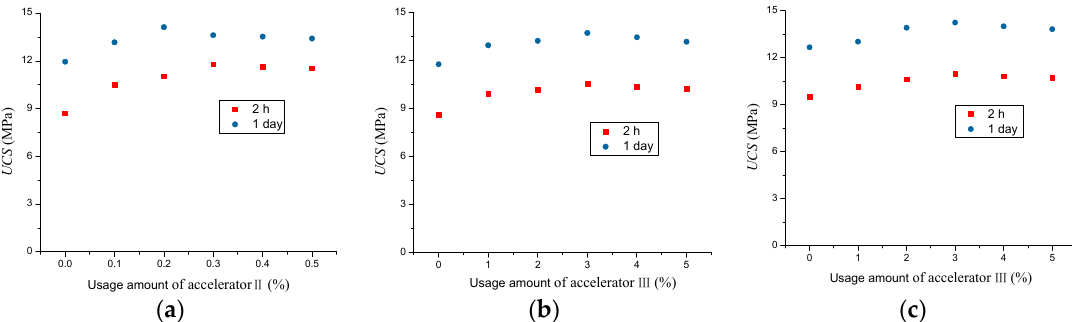
Figure 7. UCS of grouting materials with different double mixing amounts: ( a ) accelerators I and II;